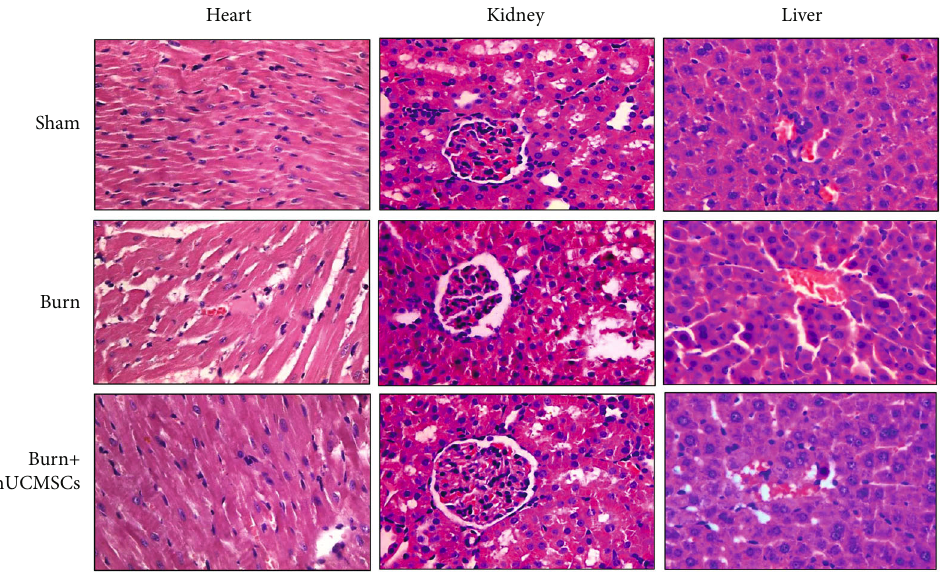
Figure 3: The hUCMSC administrations could signi fi cantly improve severe burn-induced structural damages of vital organs, such as the heart, kidney, and